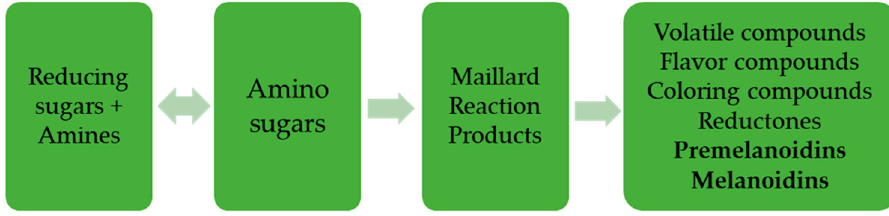
Figure 1. Maillard Reaction.